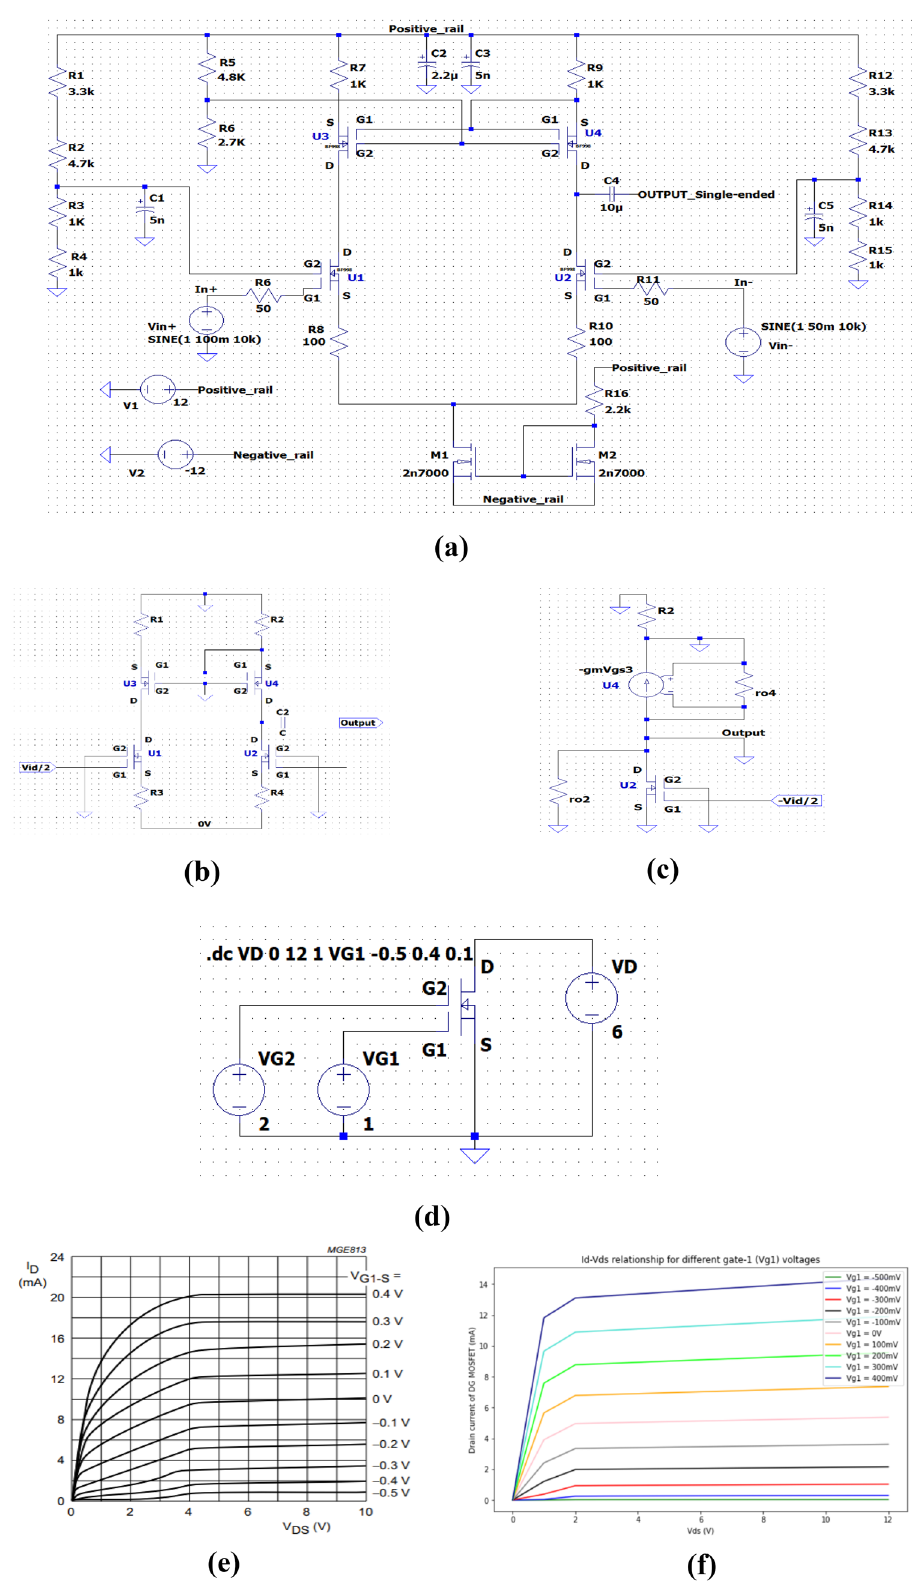
Fig. 6 a Proposed design of active-loaded differential amplifier using DG MOSFET. b Active-loaded Differential amplifier using DG MOSFET under small-signal condi- tions, c Half-circuit consisting of small-signal models of U2 and U4, d Test circuit to derive I -V characteristics e Typical D GS V characteristics from BF998 GS datasheet for V = 4 V , and f GS-2 Derived V characteristics for GS V = 2 V using the circuit in G2-S Fig.